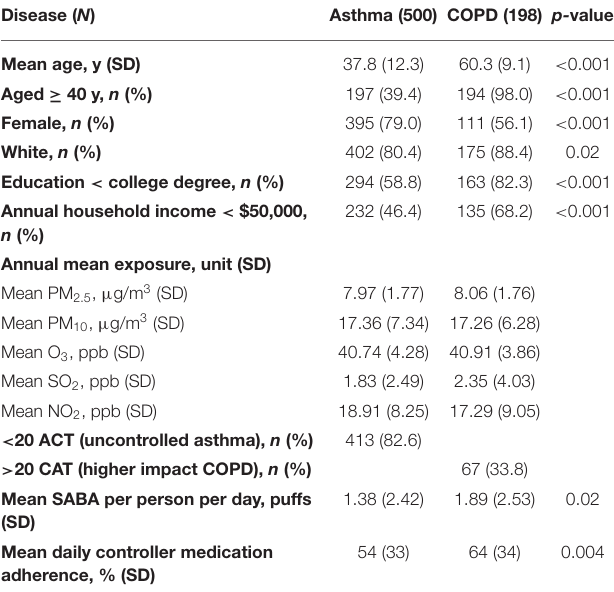
TABLE 1 | Population characteristics. Disease ( N